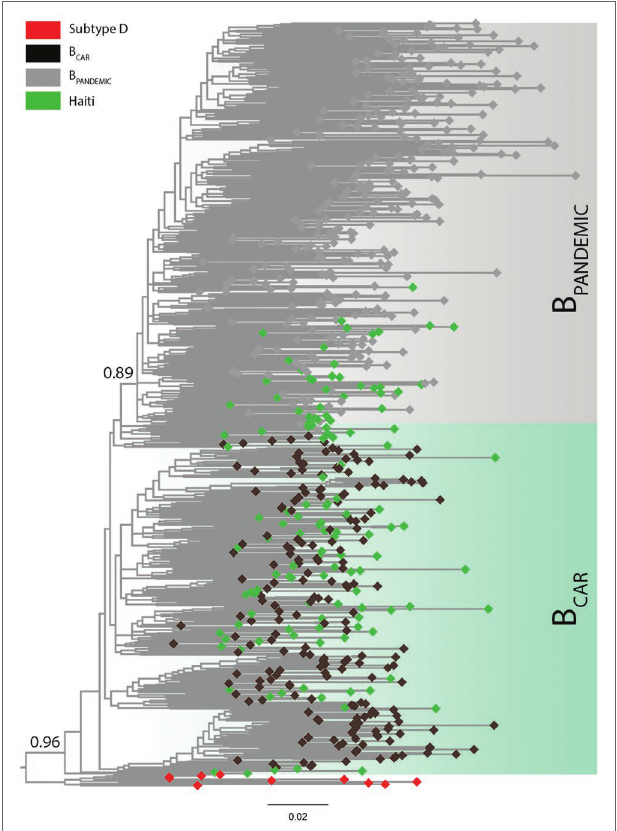
FIGURE 1 | Classification of the HIV-1 subtype B sequences from Haiti among pandemic (B PANDEMIC ) and non-pandemic (B CAR ) lineages. ML phylogenetic tree of HIV-1 subtype B pol sequences (~1,000 nt) from Haiti ( n = 127; green tips) together with representative sequences of the B PANDEMIC (US = 165, France = 135; gray tips) and the B CAR (Caribbean = 200; black tips) lineages. Node support (aLRT) for subtype B and B PANDEMIC monophyletic groups are indicated. Shaded boxes highlight the position of the B CAR and B PANDEMIC lineages. Tree was rooted using HIV-1 subtype D reference sequences (red tips). The branch lengths are drawn to scale with the bar at the bottom indicating nucleotide substitutions per